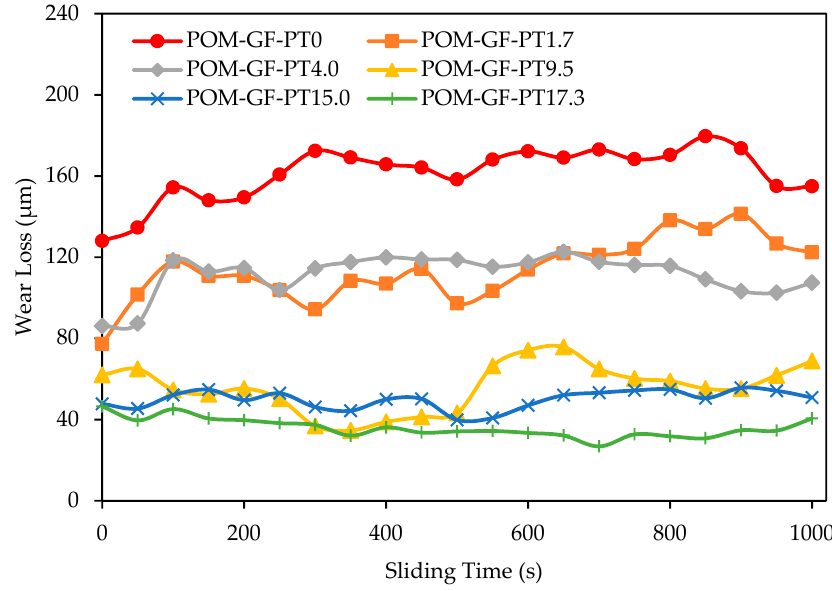
Figure 3. Characteristics of wear loss as a function of sliding time for various POM/GF/PTFE composites.